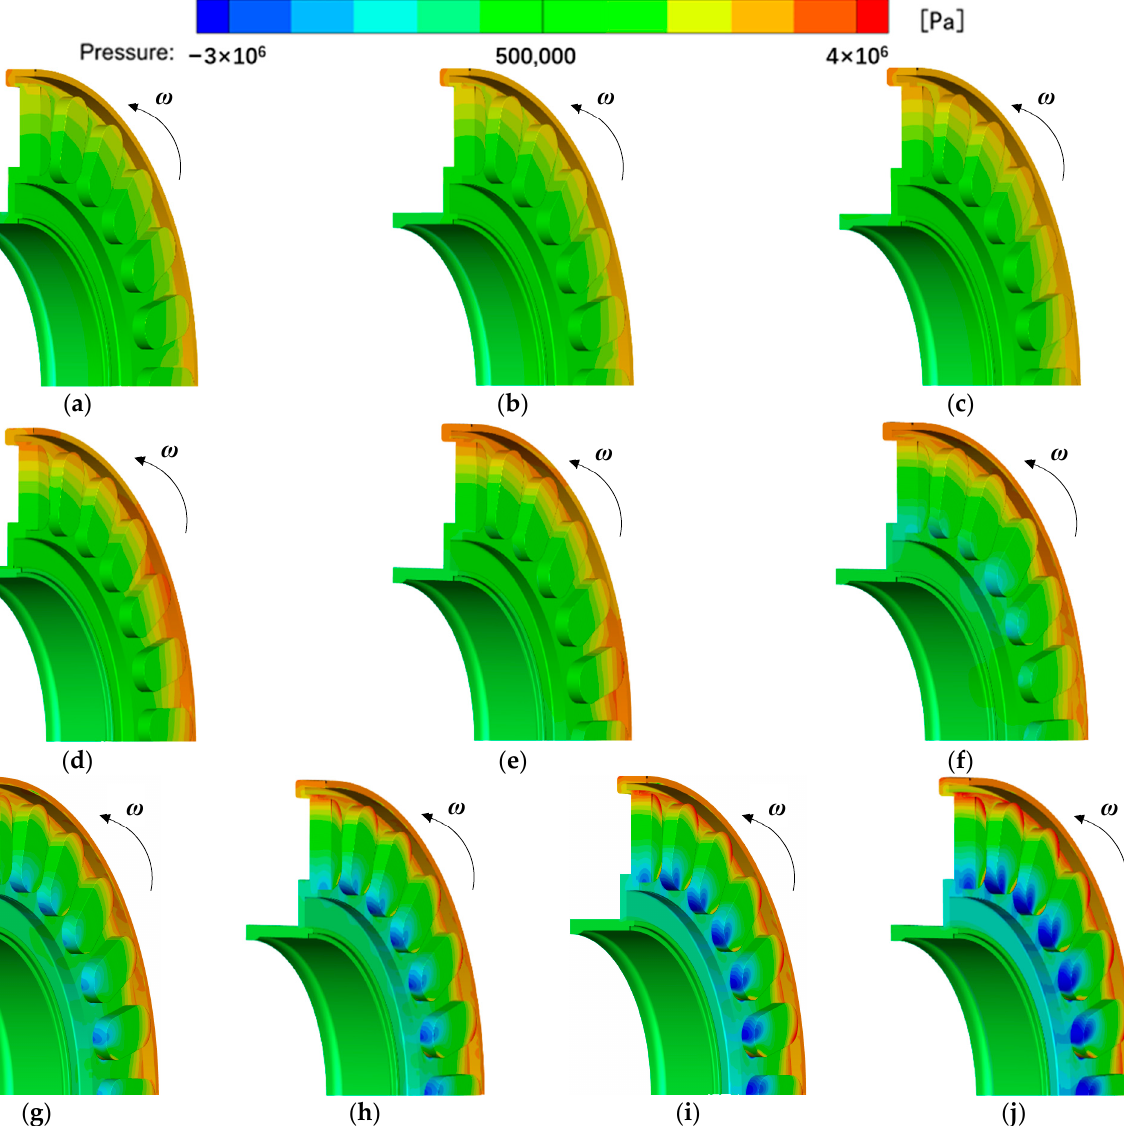
Figure 9. Pressure distribution of the first-stage liquid-sealing impeller under different rotating speeds: ( a ) 8000 rpm; ( b ) 9000 rpm; ( c ) 10,000 rpm; ( d ) 11,000 rpm; ( e ) 12,000 rpm; ( f ) 13,000 rpm; ( g ) 14,000 rpm; ( h ) 15,000 rpm; ( i ) 16,000 rpm and ( j ) 17,000 rpm.